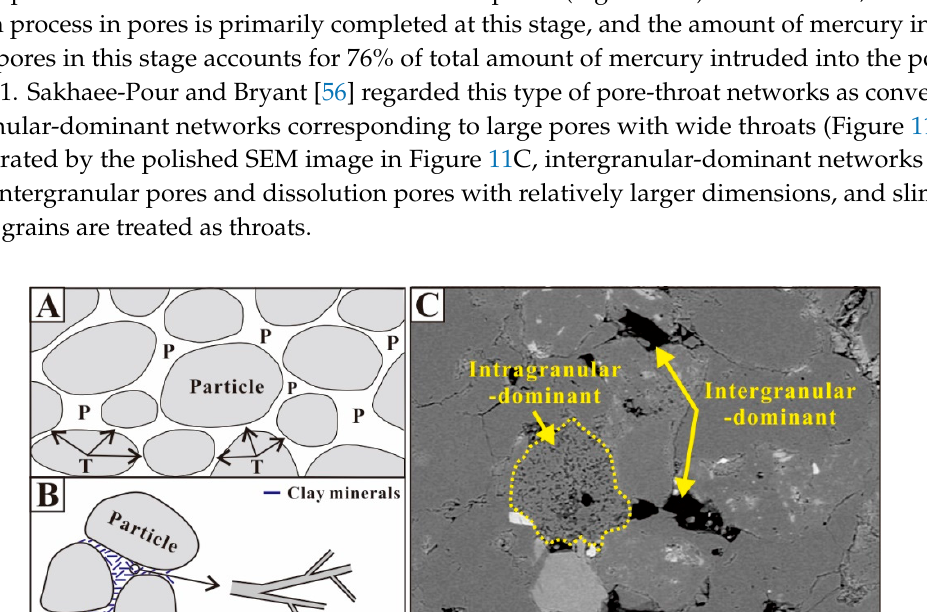
Figure 10. Surface fractal structure of throats ( A – C ) and mercury intrusion curves of total (pores + throats), pores and throats ( D – F ), derived from the RMIP experiment of three typical tight rock samples. ( A , D ): Sample #1, 0.93 mD; ( B , E ): sample #2, 2.35 mD; ( C , F ): sample #4, 0.26 mD.